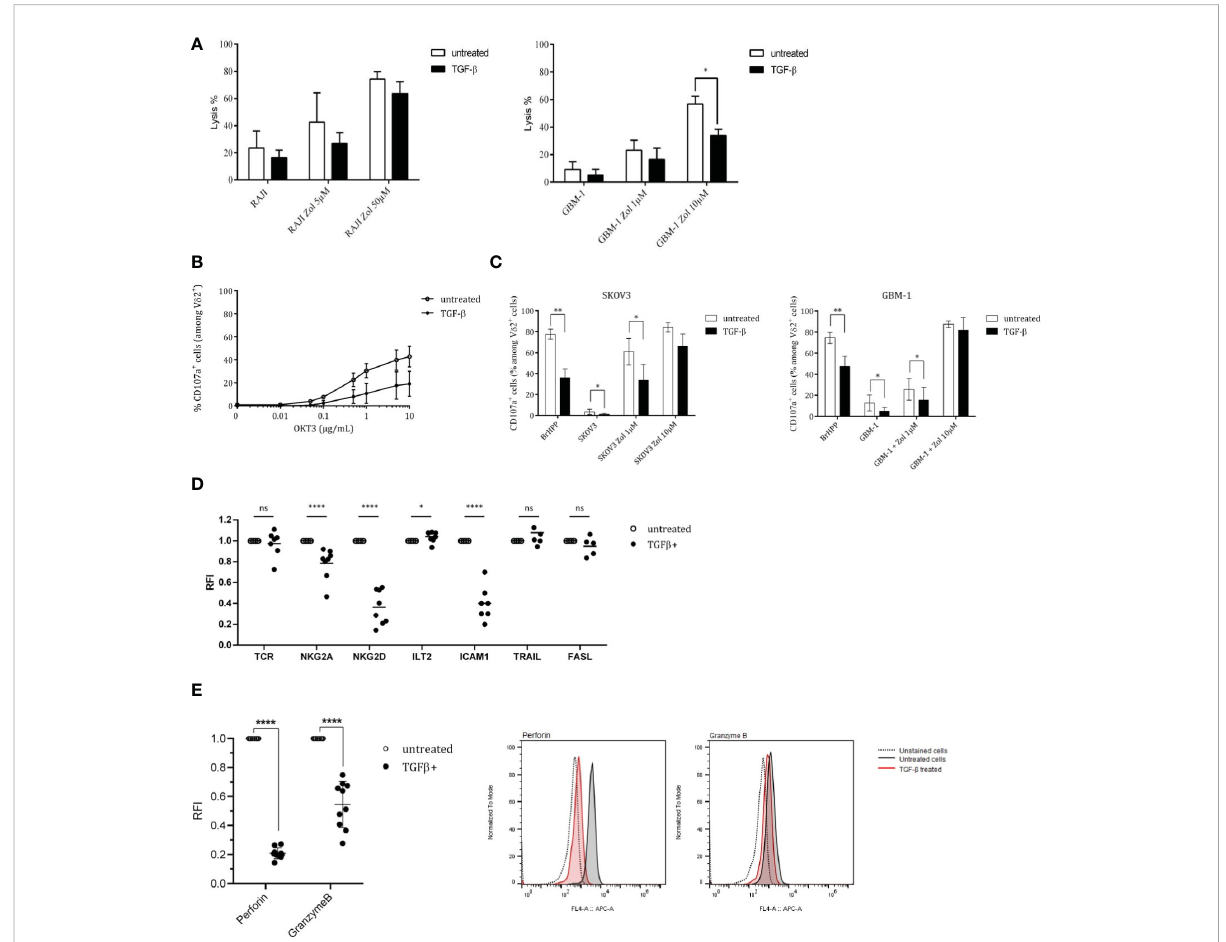
FIGURE 2 TGF- b inhibits both antitumor cytotoxicity and antigenic activation of human V g 9V d 2 T cells. PBL-derived V g 9V d 2 T cells were pretreated, or not, with TGF- b (10 ng/mL) for 72 h. (A) Cytotoxic reactivities of TGF- b -treated ( closed symbols ) vs untreated ( open symbols ) human V g 9V d 2 T lymphocytes against human tumor cells (Raji, left ; GBM-1, right ) using 51 Cr-release assays. Target cells have been sensitized, or not, with zoledronate (Zol) at 5 m M and 50 µM. Results are expressed as % of cytotoxicity (mean ± SD). (B) and (C) Frequency of CD107a + cells among TGF- b -treated ( closed symbols ) vs untreated ( open symbols ) TCR V d 2 + lymphocytes (%) after stimulation with increasing concentrations of anti- CD3 mAb (OKT3) (B) or zoledronate (Zol)-treated, or not, human SKOV3 ( left ) or GBM-1 ( right ) tumor cells (C) . E/T ratio 1/1. Positive control: BrHPP (3 µM). n ≥ 5 for (B) and (C) , mean ± SD. (D) and (E) Expression levels of activation-related molecules (TCR, NKG2A, NKG2D, ICAM1, TRAIL, FASL) (D) and cytolytic (Perforin, Granzyme B) molecules (E) by TGF- b -treated ( closed symbols ) vs untreated ( open symbols ) TCR V d 2 + lymphocytes measured by fl ow cytometry. n=8 for (D) and (E) . RFI, Relative Fluorescence Intensity. Mann-Whitney *p<0.05; **p<0.01; ****p<0.001. ns, not signi fi